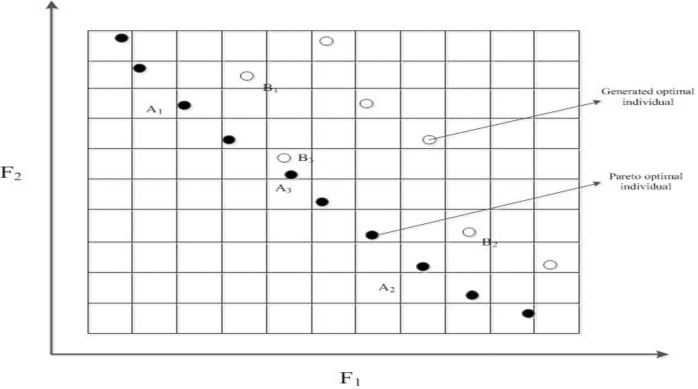
Grid-based diversity maintenance mechanism of Pareto front.